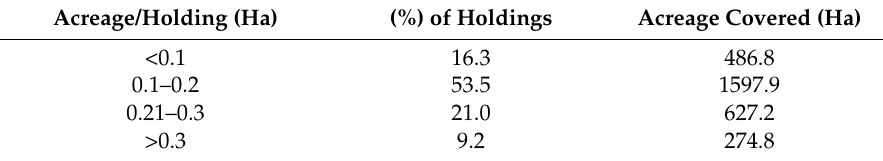
Table 1. Glasshouse holdings’ structural characteristics in Peloponnese and Crete.